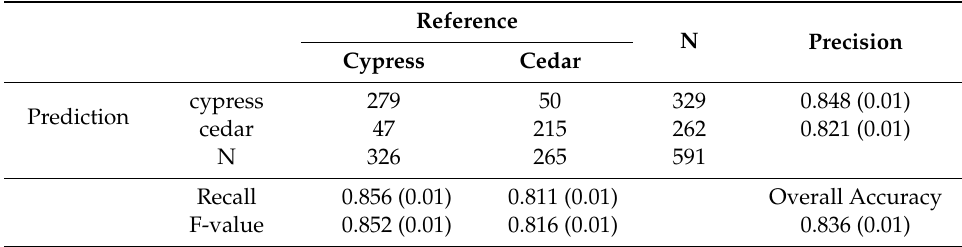
Table 5. Classification result by ResNet-200.